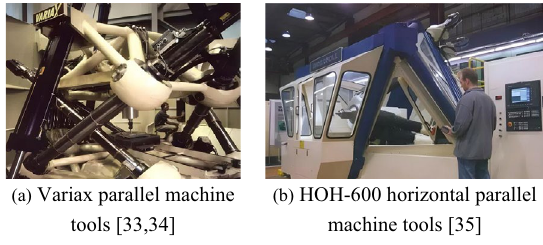
Figure 8 Early parallel machine tools products: a Variax parallel machine tools [33, 34]; b HOH-600 horizontal parallel machine tools